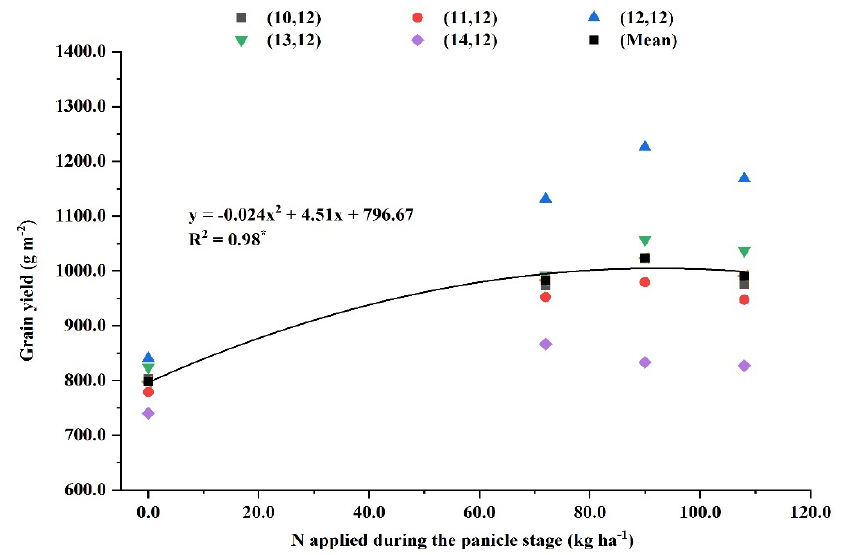
Figure 8. Correlation between yield and N fertilizer application at different leaf ages during the panicle stage. The (10,12), etc., represent the patterns of different applications of N and K at the panicle stage. * p < 0.05.